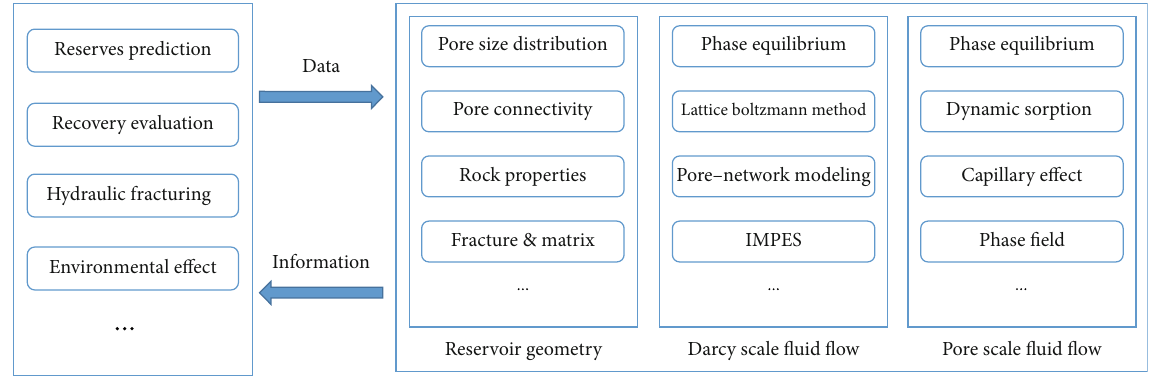
Figure 1: Design of a digital twin for unconventional